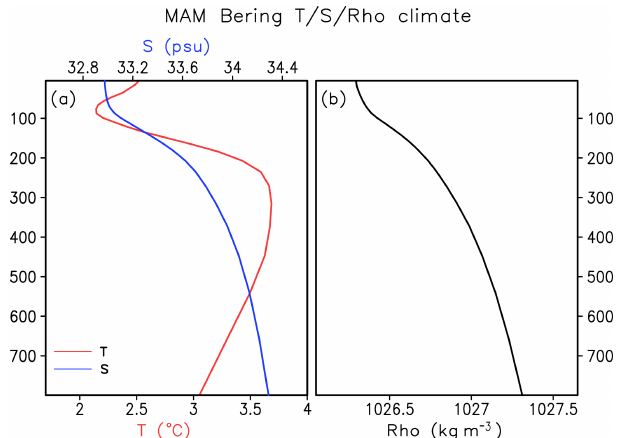
Figure 12. Climatological vertical profile of spring (March–May) Bering deep basin (50–60 ◦ N, 160–190 ◦ E) mean temperature and salinity (a) and density (b) .